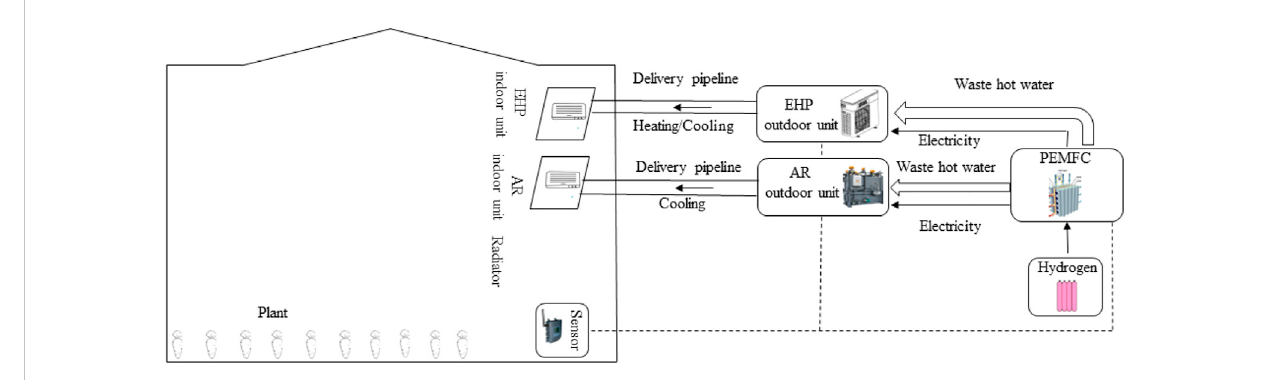
FIGURE 7 Triple cogeneration system for a hydrogen fuel cell in a